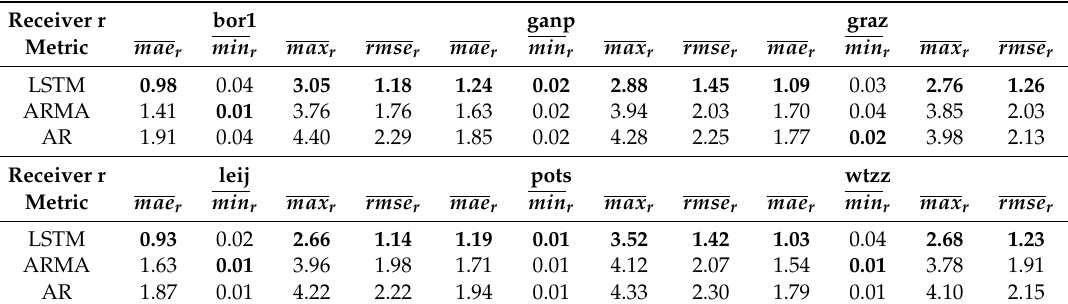
Table 3. Performance metrics (mean, minimum (Min), maximum (Max) and root mean squared error (rmse)) for VTEC (TECU) prediction for six selected stations (bor1, ganp, graz, leij, pots and wtzz) among the proposed solution (LSTM) and two other commonly used methods (ARMA,